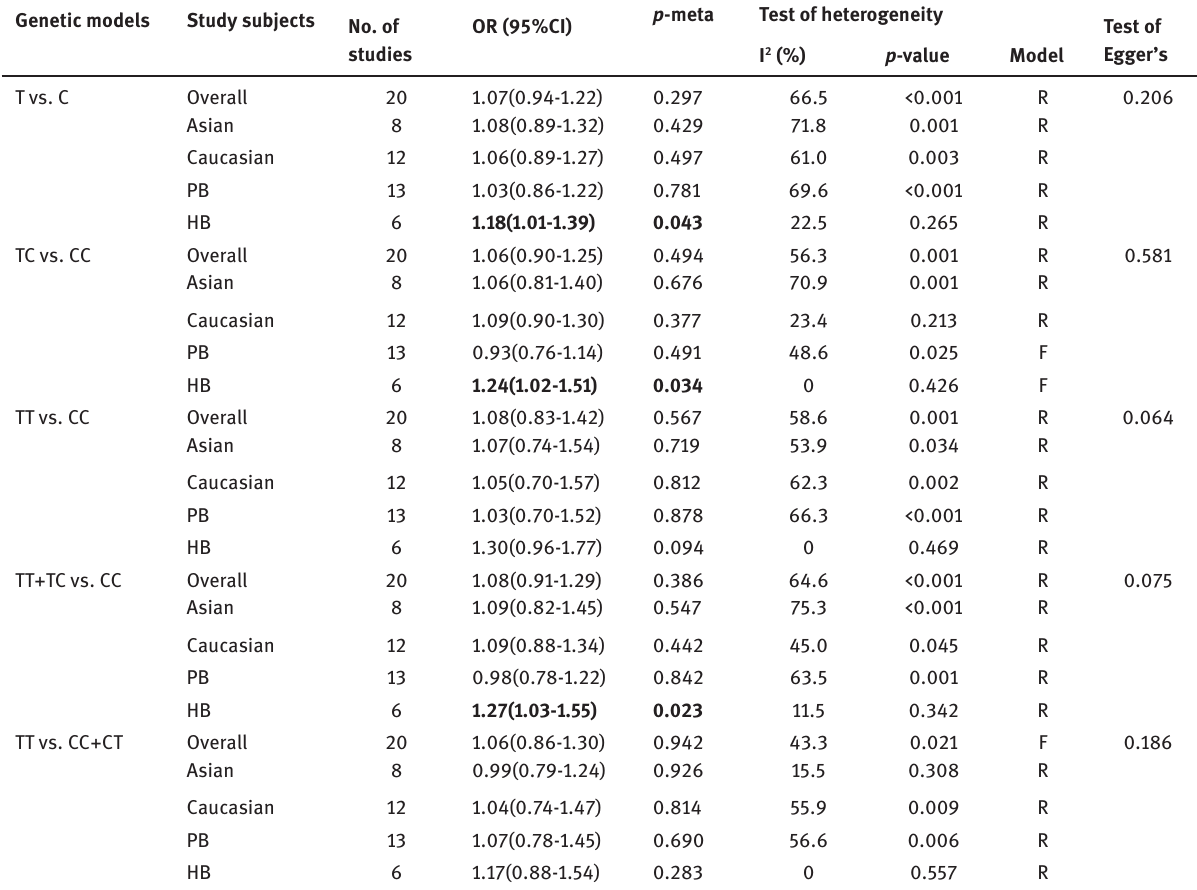
Table 2 : Summary ORs and 95%CI of the association between C677T polymorphism and Parkinson disease susceptibility.